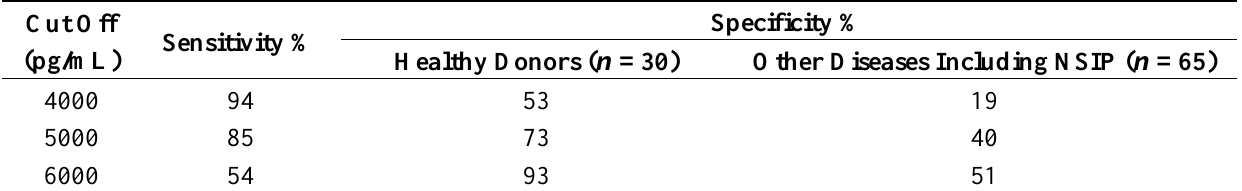
Table 4. Sensitivity and specificity values of serum MMP-7 levels in discriminating between NSCLC patients (48) and healthy donors or individuals with other lung diseases.